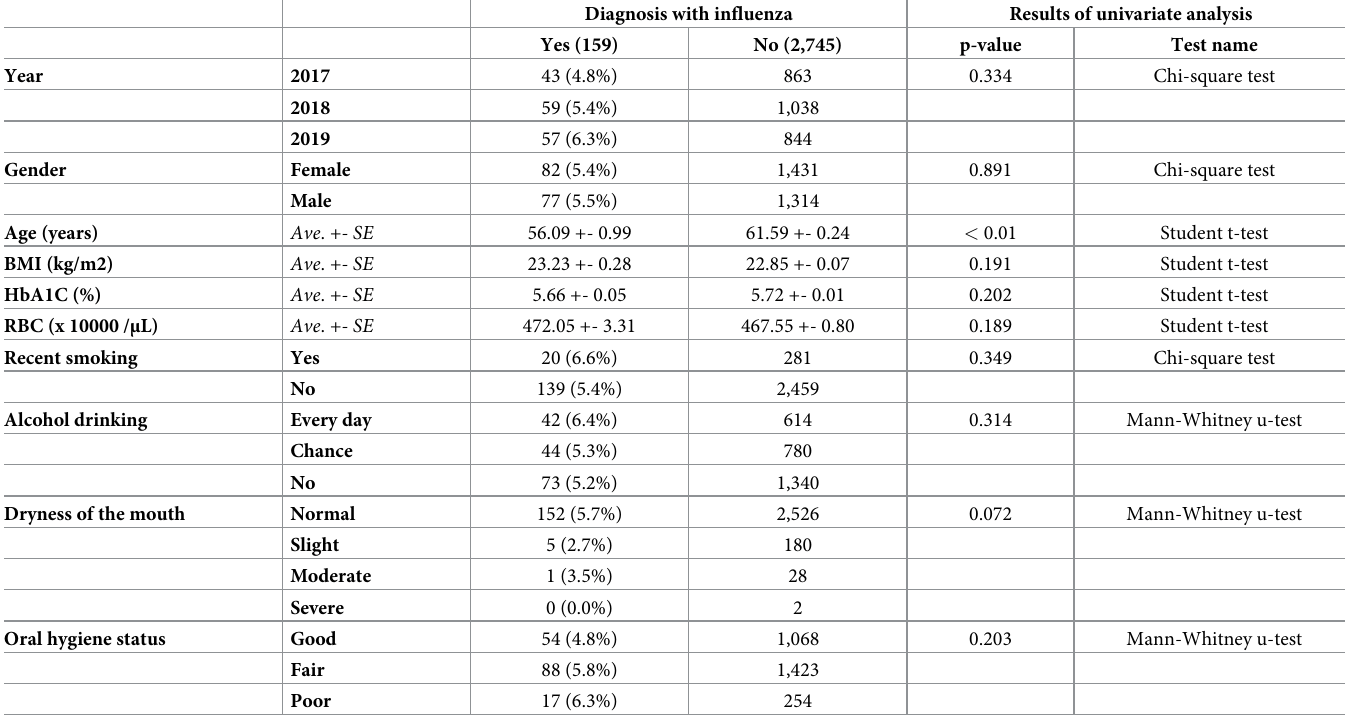
Table 2. Result of univariate analyses assessing the correlation between influenza infection and risk factors including oral condition.